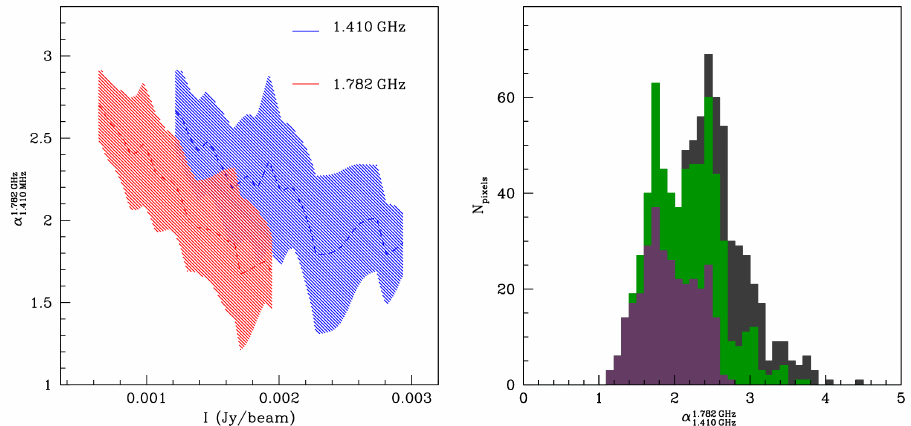
Figure 3. Spectral index versus radio brightness at 1.410GHz in blue and at 1.782GHz in red (left panel). Spectral index histogram for a cut in 1.782GHz radio brightness of 0.5 (dark gray), 0.8 (green), and 1.3mJy/beam (purple), as the contours shown in Figure2. See text for more